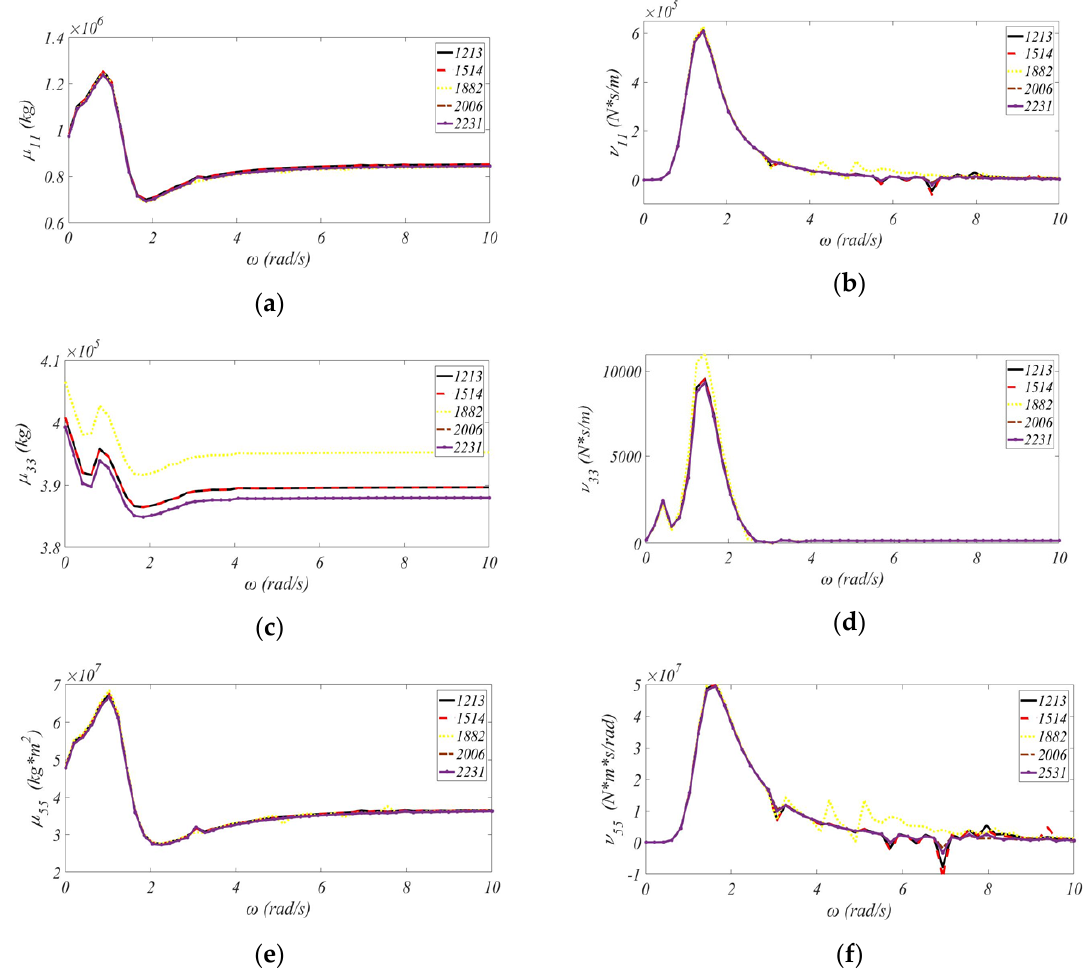
Figure 12. The mesh convergences for hydrodynamic coefficients ( a ) µ 11 ; ( b ) ν 11 ; ( c ) µ 33 ; ( d ) ν 33 ; ( e ) µ 55 ; and ( f ) ν 55 of the NREL/MIT TLP wetted hull under different panel numbers.